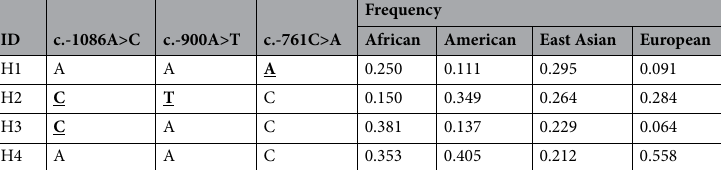
Table 2. Frequencies of ABCA4 proximal promoter haplotypes. SNPs are marked with bold-faced letters. Minor alleles are marked in underlined letters.